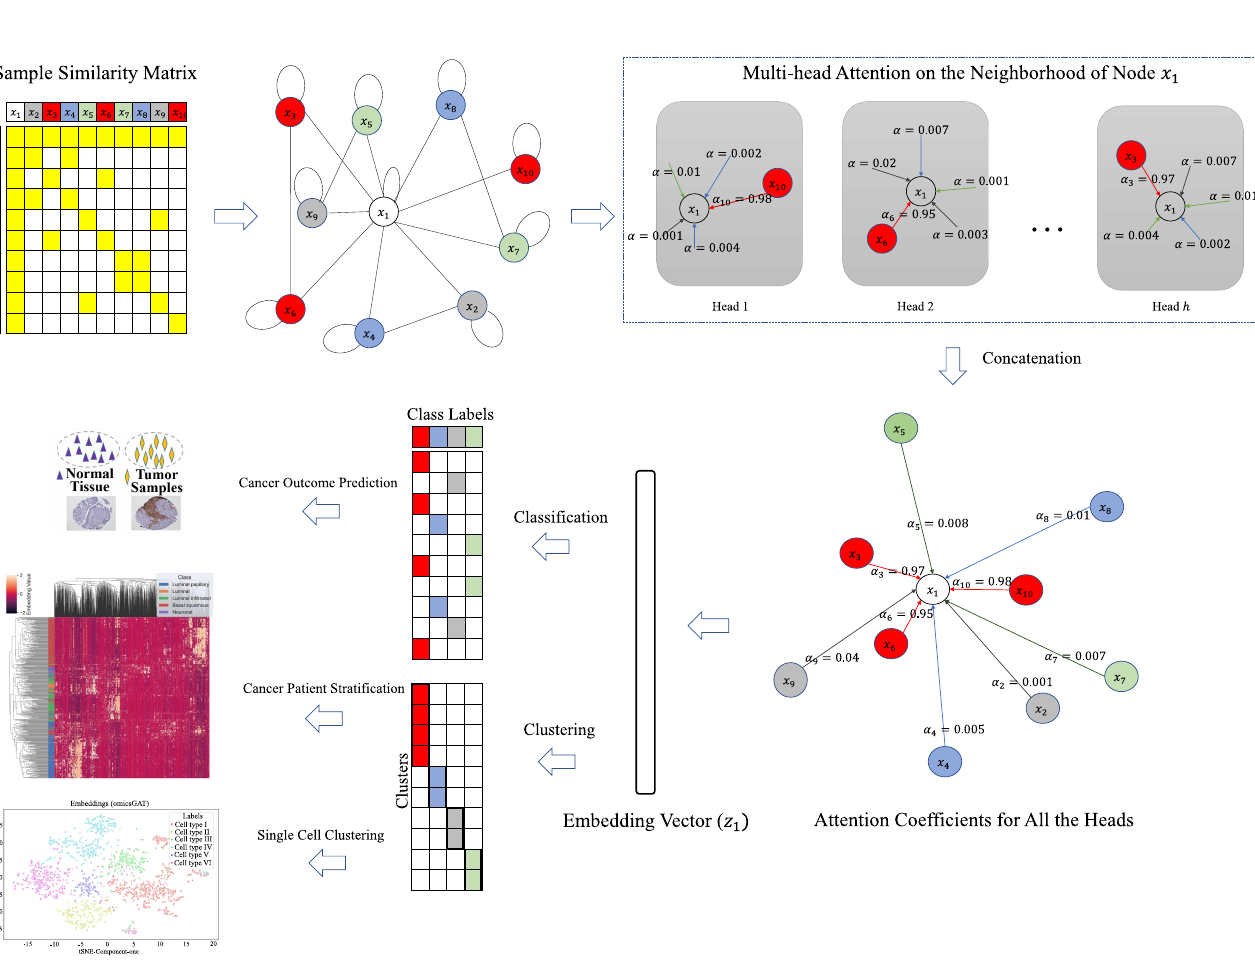
Figure 6. Workflow of omicsGAT. For a sample x 1 , based on the input feature matrix and adjacency matrix, each head calculates the attention given to x 1 from its neighbors separately. The embeddings produced by all heads are concatenated together to generate the final embedding z 1 for x 1 , which is then used for classification or clustering of x 1